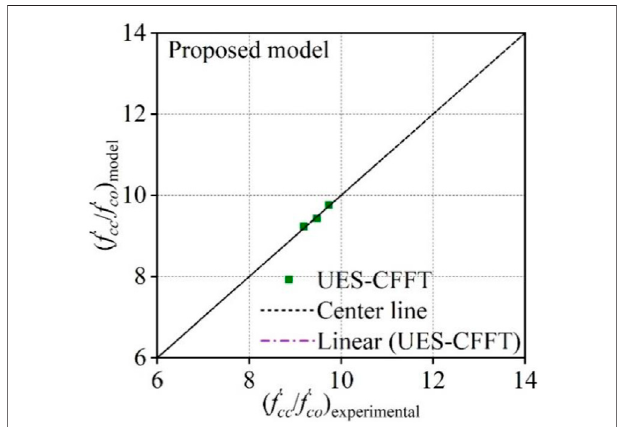
FIGURE 10 | Performance of the proposed new model in predicting strength enhancement